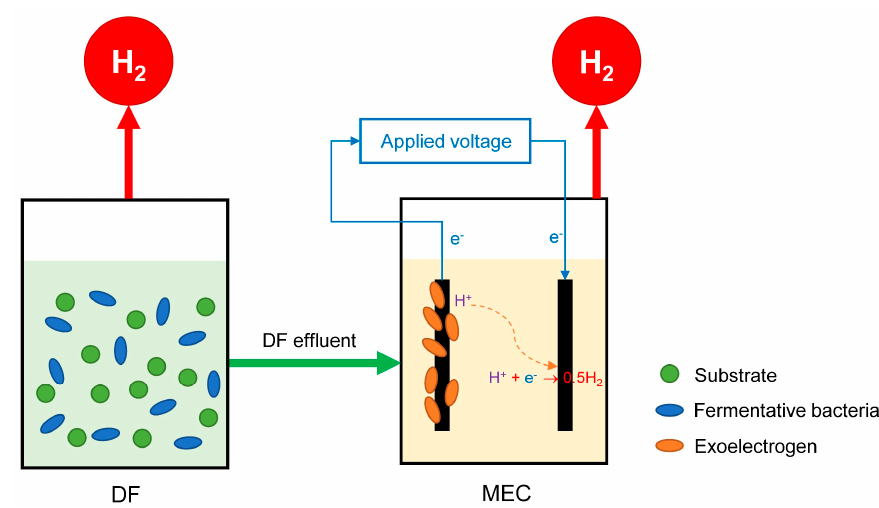
Figure 5. Diagram of the two-stage DF and MEC process (DF-MEC).